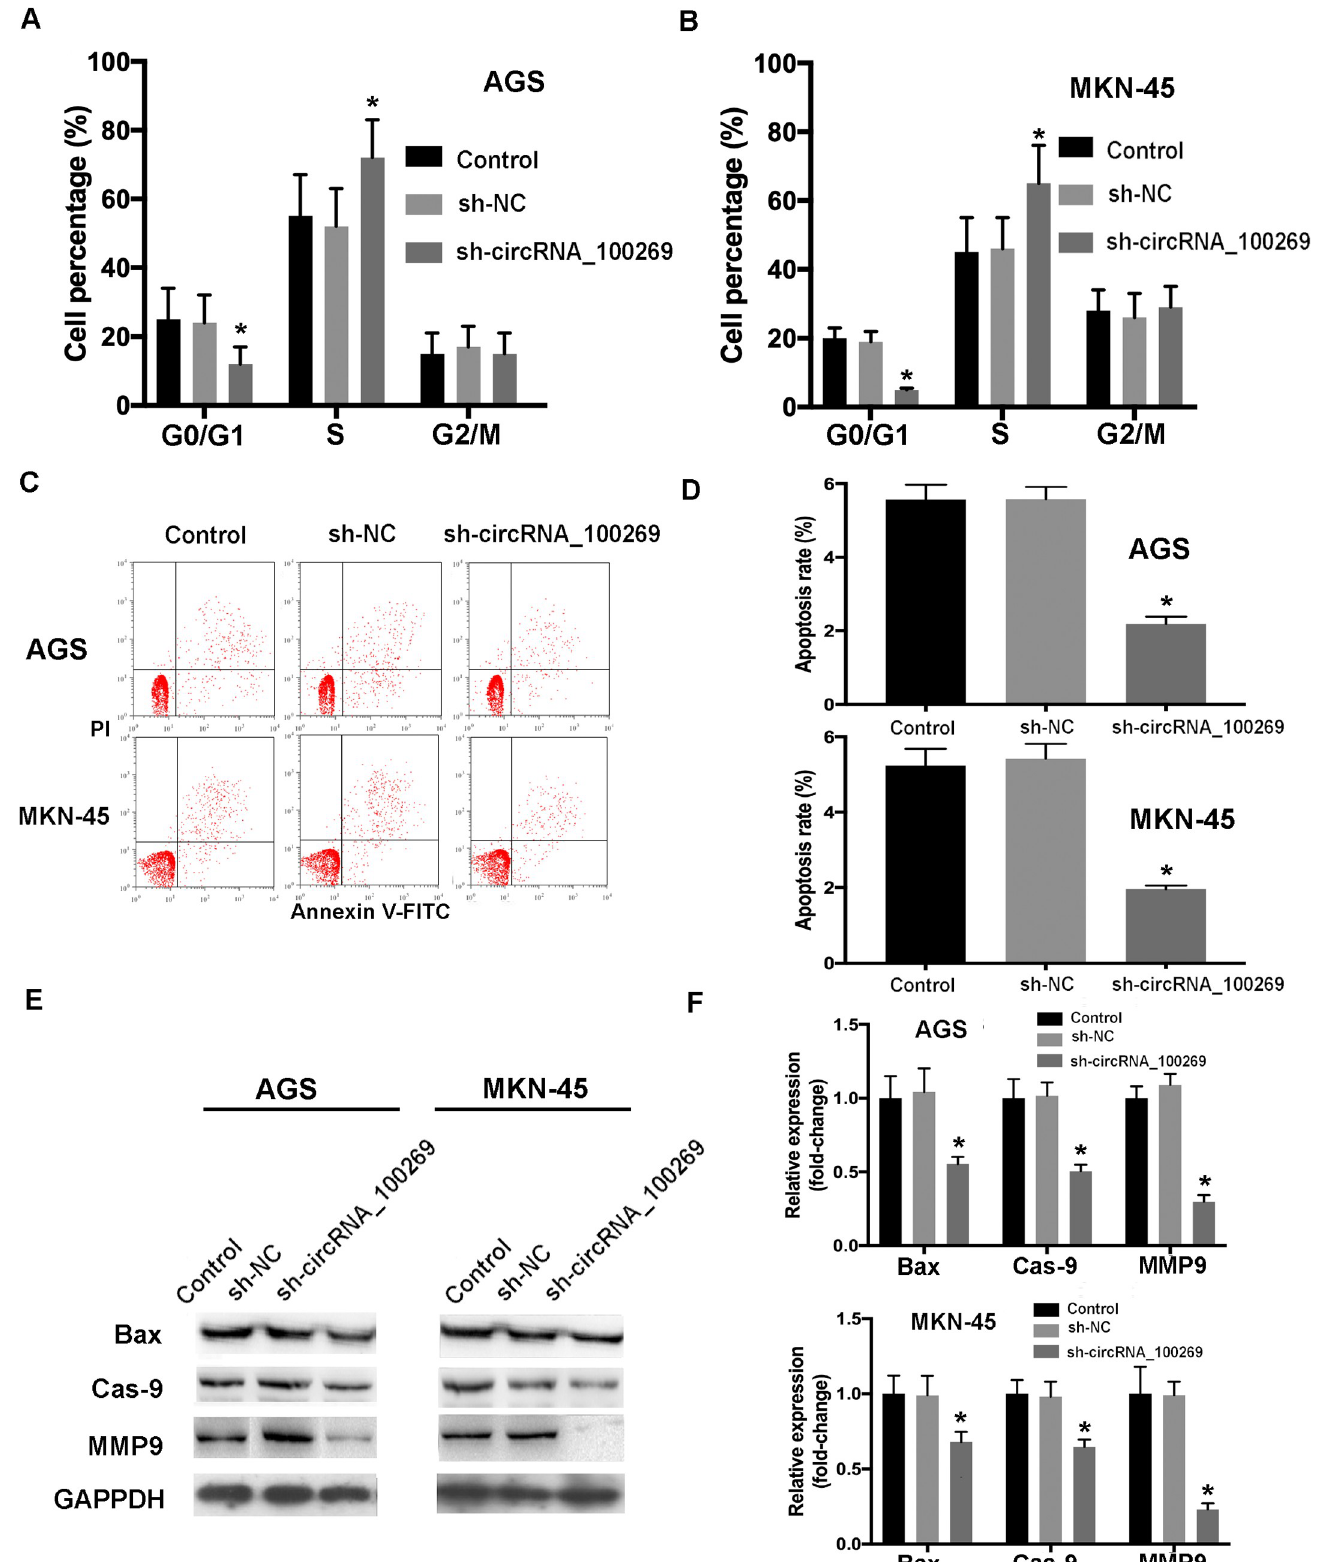
Fig 5. Knockdown of hsa_circRNA_100269 inhibits cell cycle arrest and apoptosis of GC cells. (A and B) The distribution of cell cycle and apoptosis in GC cells transfected with sh-hsa_circRNA_100269 were determined. (C-F) The apoptosis of AGS and MKN-45 cells with hsa_circRNA_100269 knockdown were also examined compared with the controls. All the experiments were performed in triplicate. � P < 0.05 vs. non-transfected cells. GC, gastric cancer. https://doi.org/10.1371/journal.pone.0250603.g005 PLOS ONE | https://doi.org/10.1371/journal.pone.0250603 April 26,